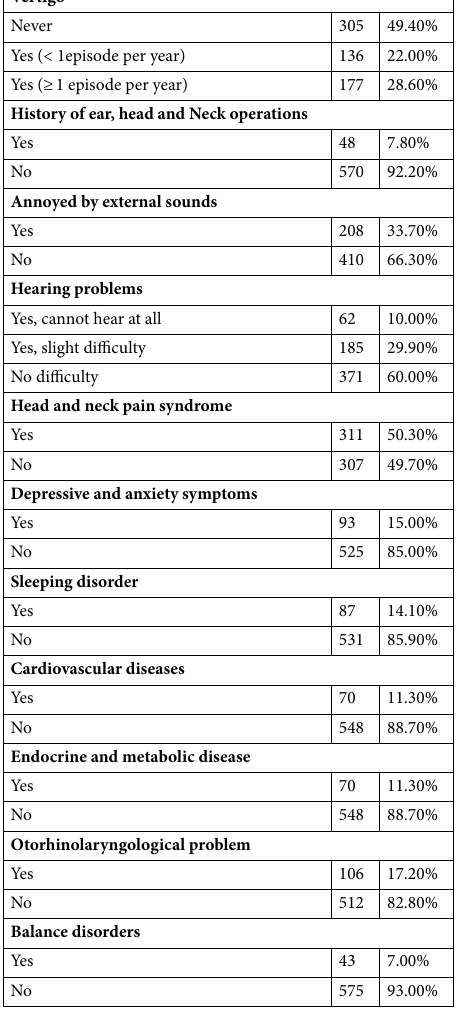
Table 2. Clinical characteristics of the study participants (n = 618).